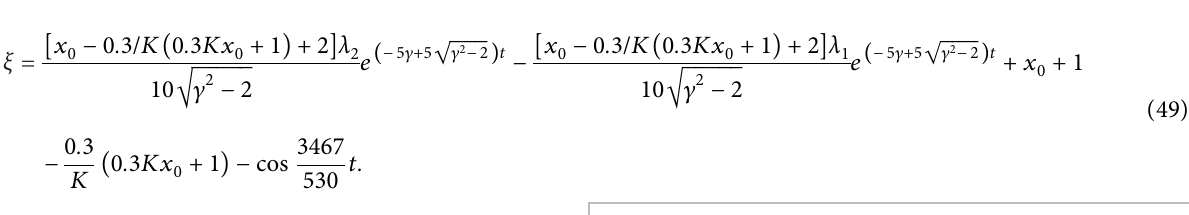
Figure 13: The running track diagram of the carbon brush when the precompression is 0.4mm ∼